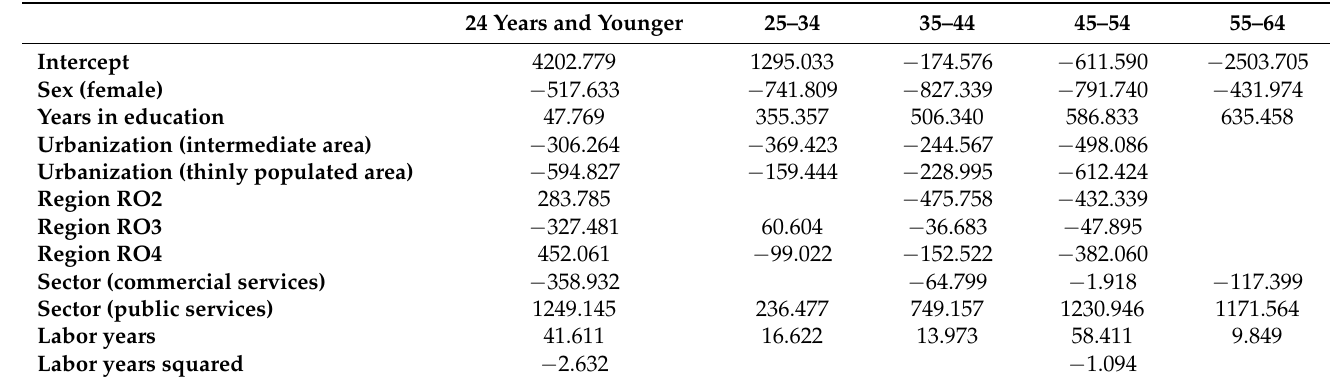
Table A1. Coefficients for model 1 using the absolute measure of education.